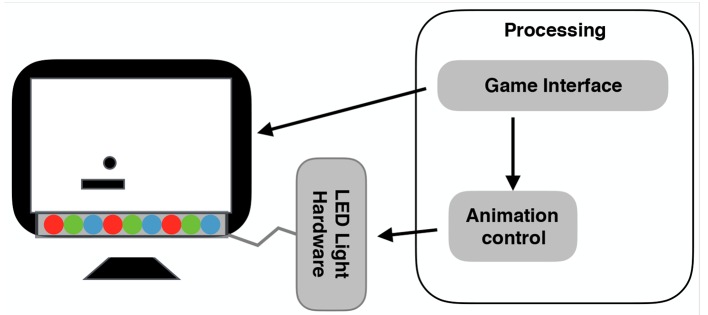
System overview.